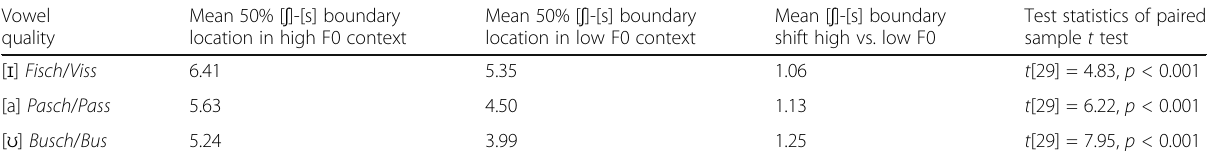
Table 4 Mean 50% phoneme boundary locations in the [ ʃ ]-[s] sibilant continuum, estimated by means of logistic regression curves derived from response patterns in the high and low F0 contexts of each vowel quality condition